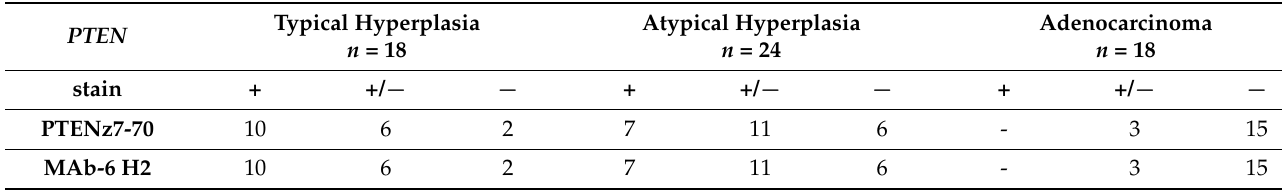
Table 2. The PTENz7-70 dual aptamer reproduced the signal obtained with Mab-6H2 monoclonal specifically in a panel of neoplasic and hyperplasic endometrium tissue. The presence of PTEN in all acini was indicated as positive (+). The absence of PTEN in all ducts was stated as minus ( − ). Partial loss of PTEN were indicated as (+/ − ) in hyperplasic tissue. The results show that both the PTENz7-70 dual aptamer and theMAb-6H2 produce identical a signal with identical intensity and pattern in a panel of 60